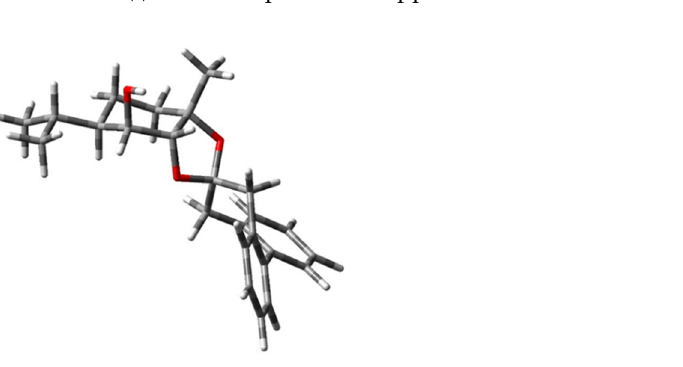
Figure 5. Experimental UV (blue line) and ECD (red line) spectra of 3 in CH 3 CN.